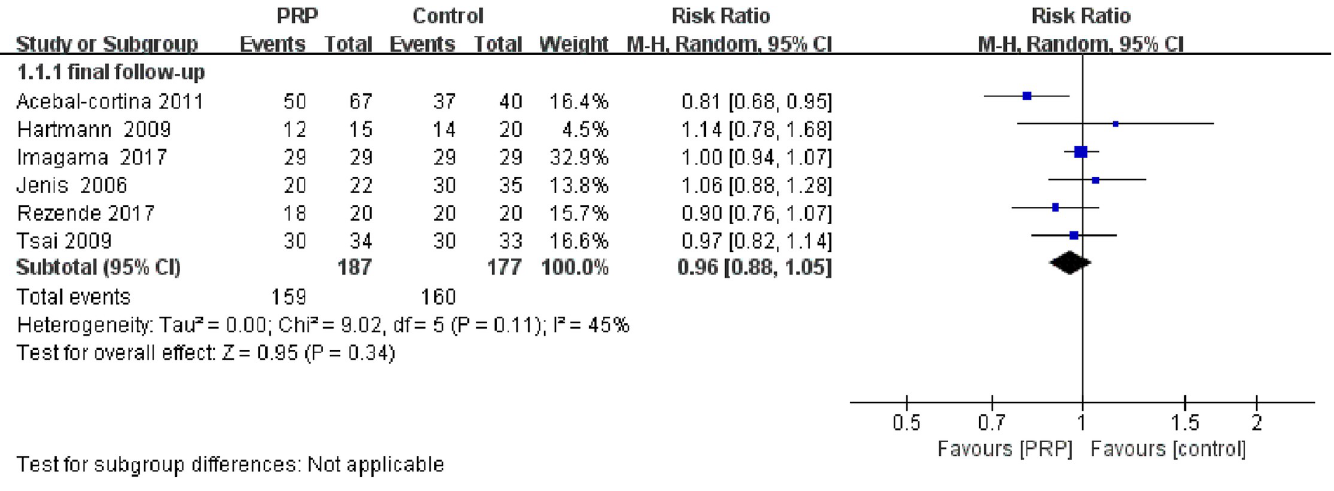
Fig 2. Forest plot of the fusion rate in cohort